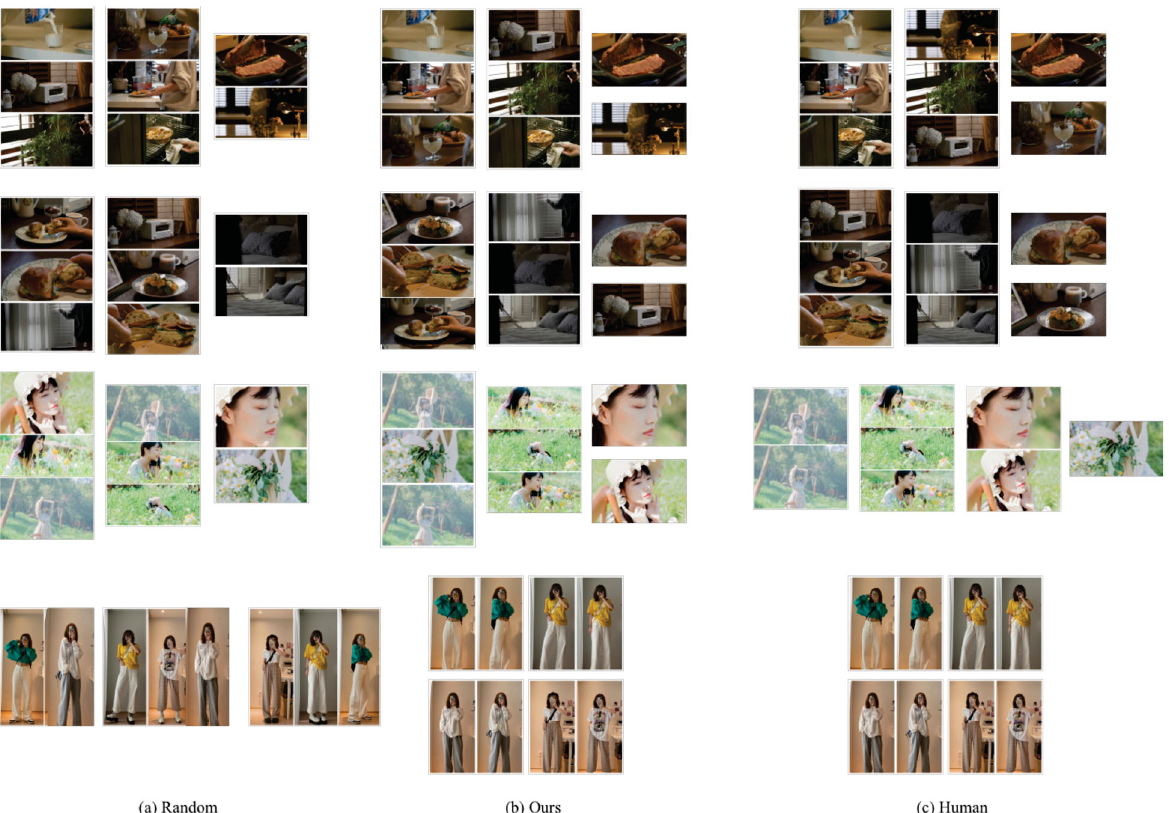
Fig. 10 Results of the comparative